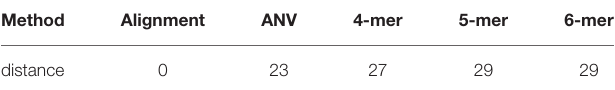
TABLE 5 | Robinson-Foulds distances between trees by alignment-free methods and the reliable alignment tree.